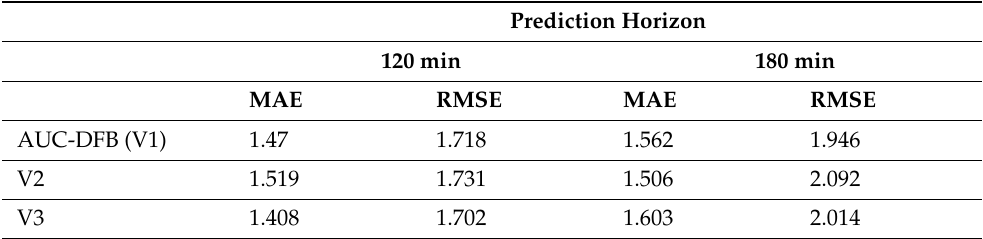
Table 10. Cross-validation results for the AUC-DFB version, all values in mmol/L. The V1 version is the model trained with the training/validation data division as described above, while the V2 and V3 versions use another third of the samples for